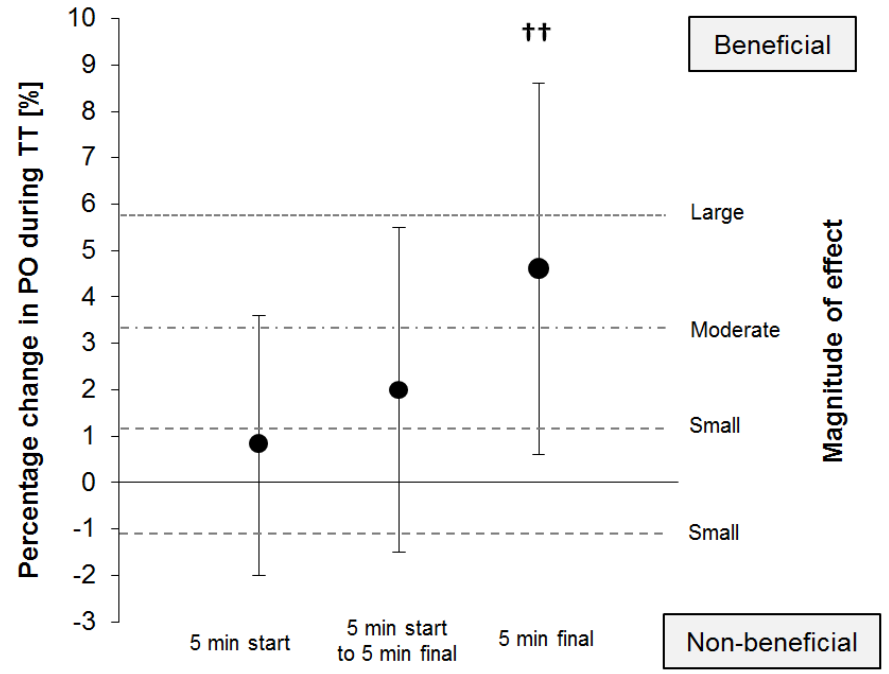
Figure 2. Percentage change and 90% CI of power output between the PSE and MDX trials during the first 5 min, the final 5 min, and the intermediate period of the time trial ( N = 20). Thresholds for small, moderate, and large effects are indicated by dashed lines. †† denotes a likely small benefit, i.e., higher power output with PSE compared with MDX.